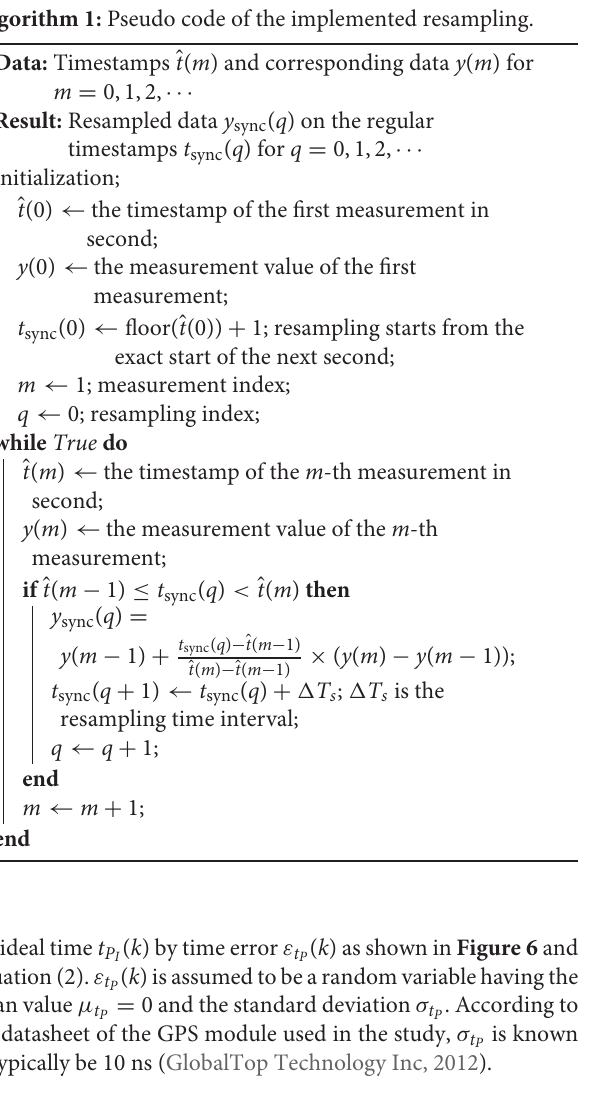
Frontiers in Built Environment |